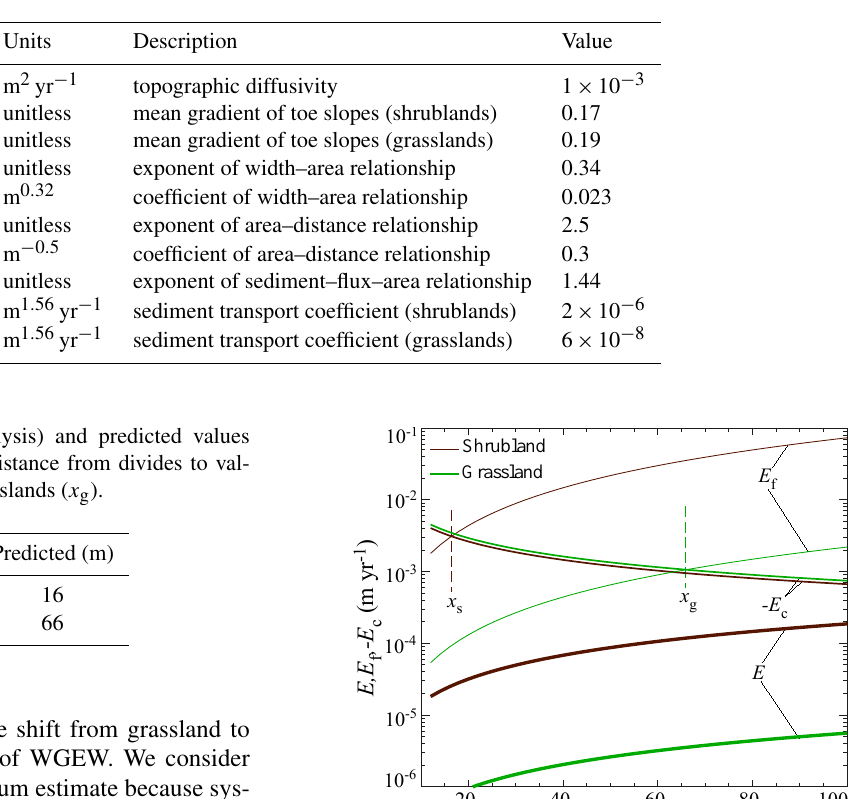
Table 2. List of model parameters and values.